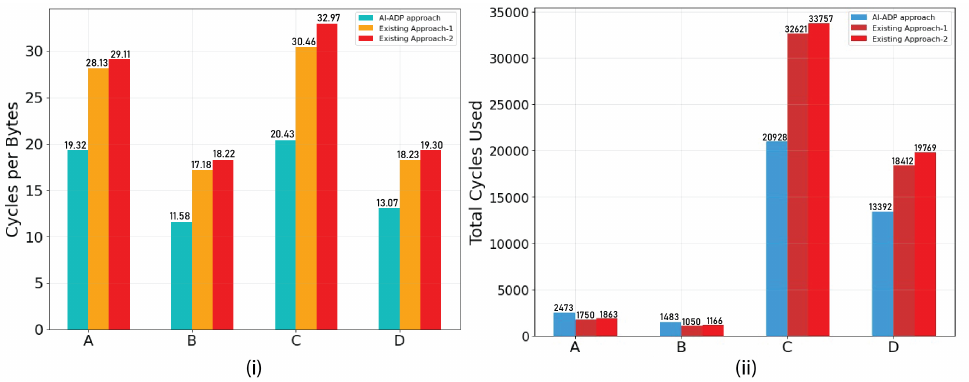
Figure 10. A comparative analysis of the AI-ADP scheme with existing approaches: ( i ) Cycles used per byte and ( ii ) total cycles